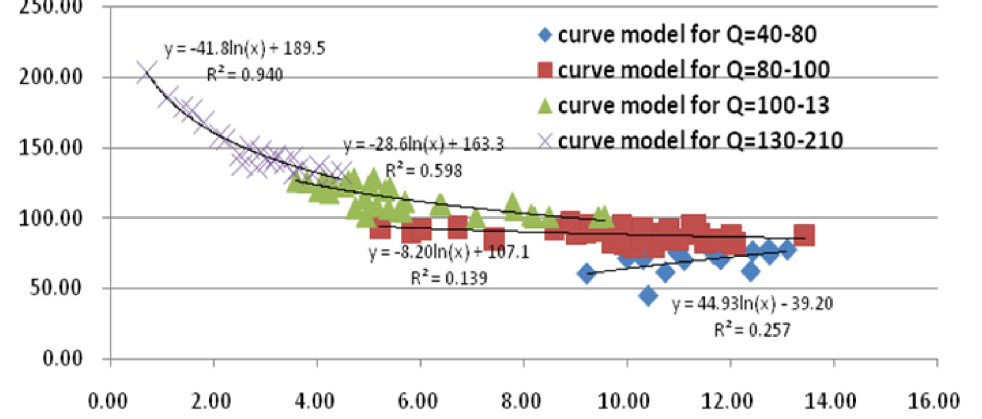
Figure 11. Fitting model of signal strength in different distance